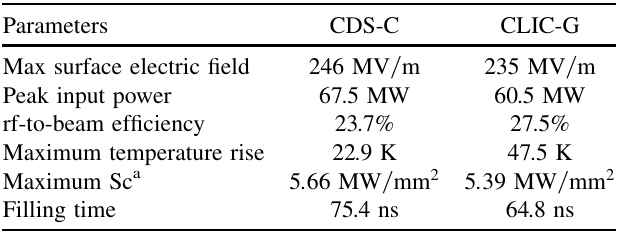
TABLE IV. The rf parameters of CDS-C and CLIC-G.